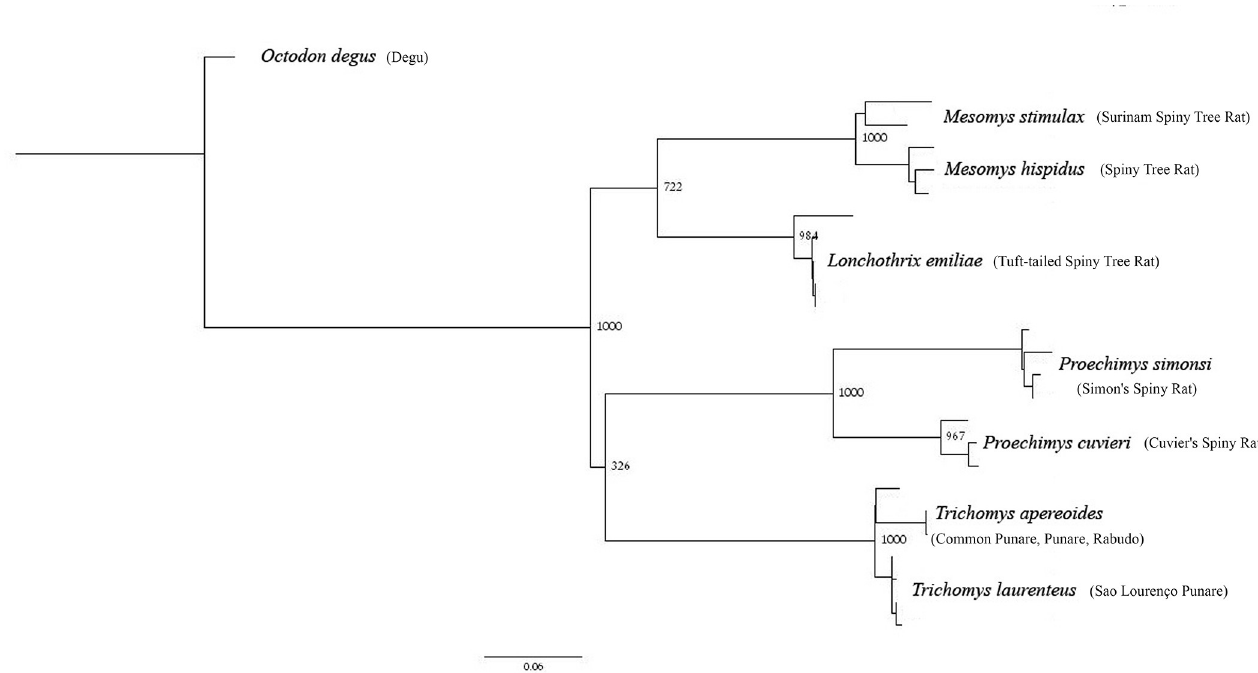
Fig 4. Maximum likelihood tree for seven Echimyidae species obtained using PhyML, based on the mitochondrial gene Cyt b (803 bp). The numbers near the nodes are bootstrap values for 1,000 replicates. Species common names are within the parenthesis.